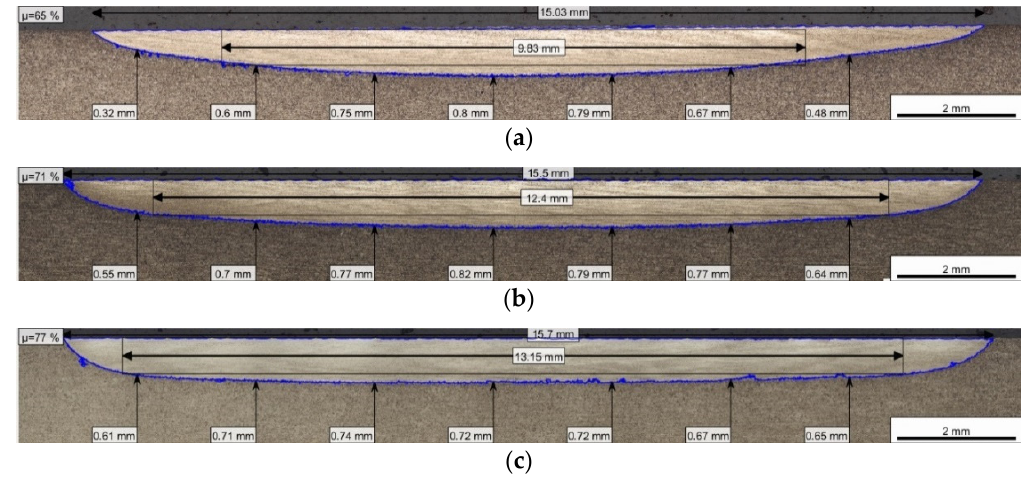
Figure 9. Analysis of the hardened track of the specimen after polishing and etching. The specimen were hardened with an optimized intensity profile at feed of 300 ( a ), 400 ( b ) and 500 mm/min ( c ). It is apparent that the grain structure of the optimized temperature profile, which can be seen in